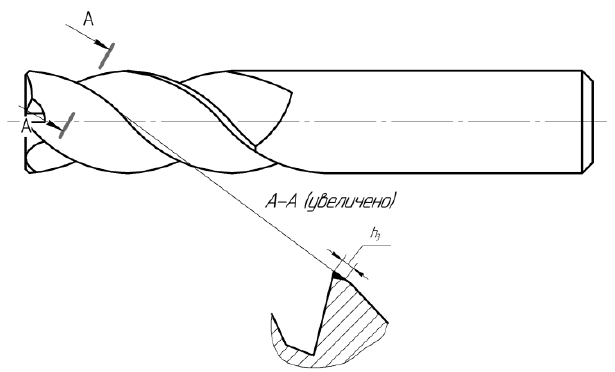
Figure 2. Method for determining the value of h3.